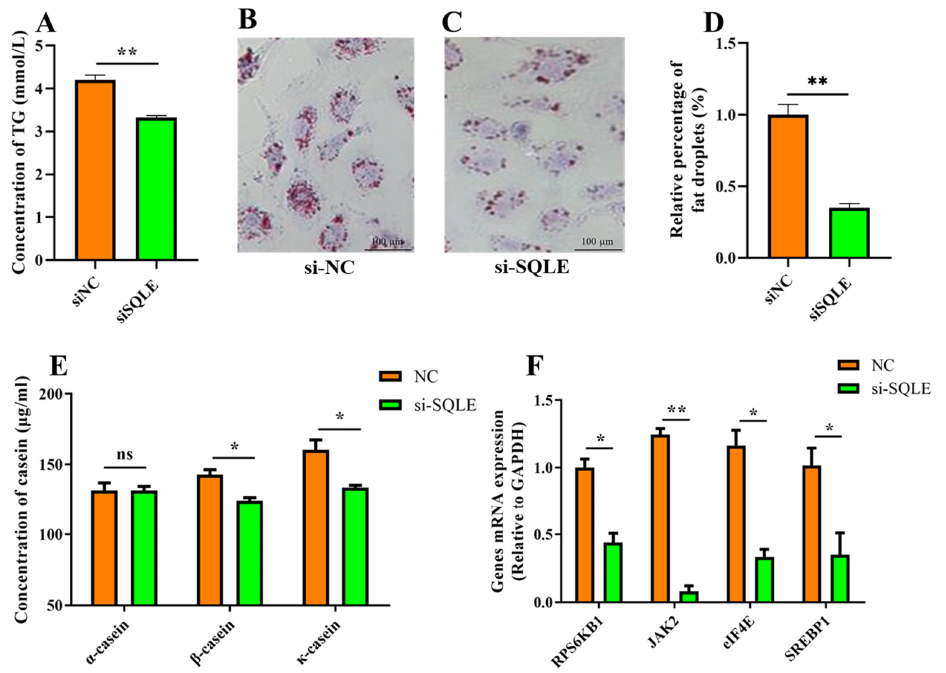
Figure 5. SQLE regulate lipogenesis and casein synthesis in BuMECs. ( A ) Triglyceride concentration was detected in the cell lysate. Triglyceride concentration was normalized by control; ( B – D ) Oil red O staining was used to indicate the lipid droplet secretion of BufMECs (Scare bars: 100 μ m); ( E ) content of α -casein, β -casein, and κ -casein in the BuMECs culture supernatant was determined by ELISA. ( F ) mRNA expression of milk fat and protein synthesis-related genes after SQLE knockdown, and GAPDH was used as the inner control. n = 3 biological replicates. * p < 0.05, ** p < 0.01, ns: nonsignificant difference, compared with control group. Error bars represent SEM.